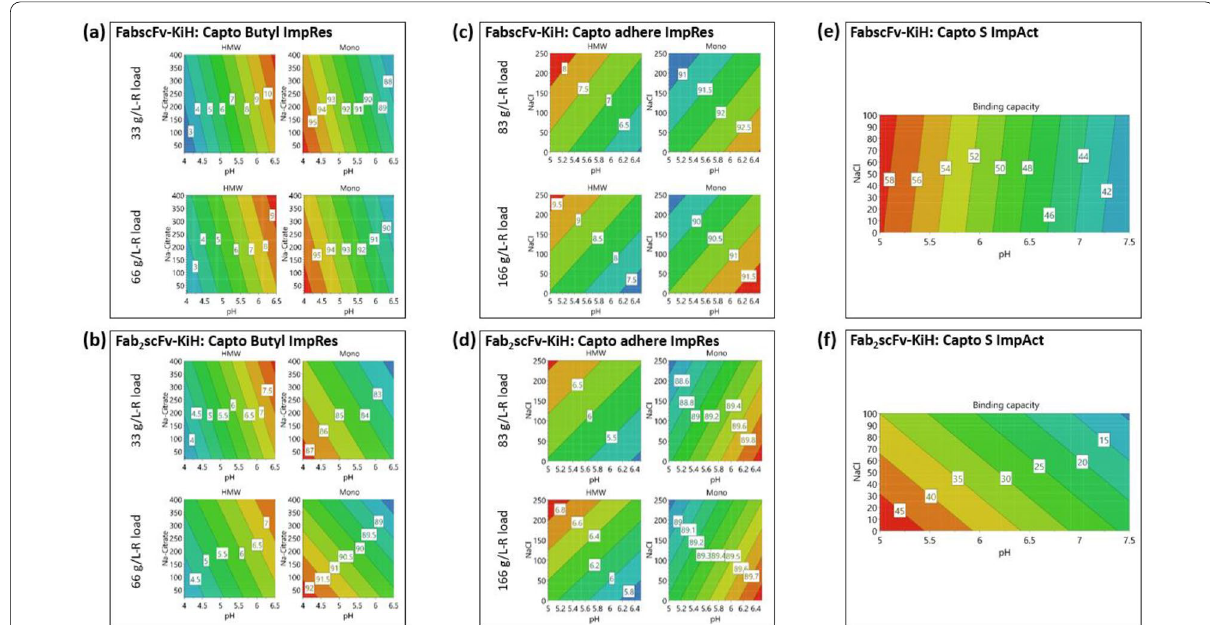
Fig. 3 Contour plots obtained from DoE software after screening in 96-well plate format of Capto Butyl ImpRes ( a , b ), Capto adhere ImpRes ( c , d ), Capto S ImpAct resins ( e , f ) for both FabscFv-KiH and Fab 2